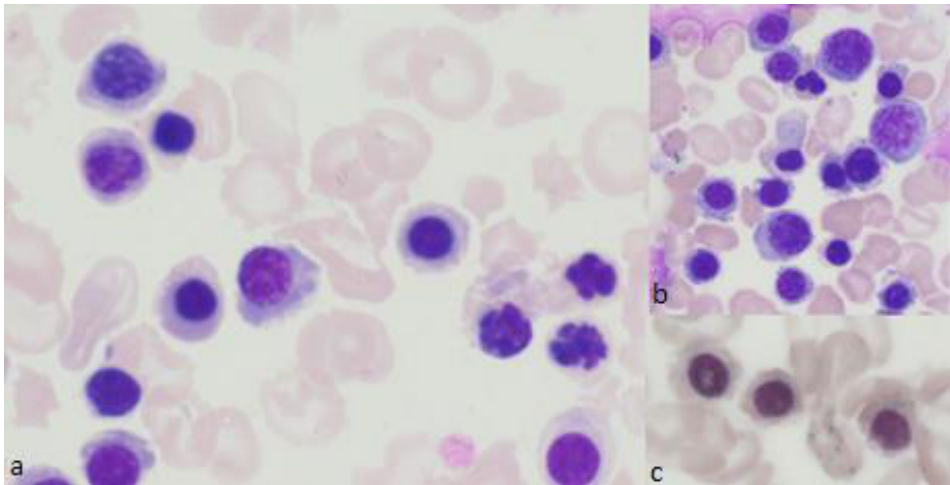
Figure 4. Representative bone marrow smears from a patient with SFID syndrome. ( a , b ) Bone marrow smears showing acidophilic erythroblasts with basophilic stippling and karyorrhexis (May-Grünwald-Giemsa), magnification ×1000. ( c ) Perls’ stain shows ring sideroblasts, magnification ×1000.